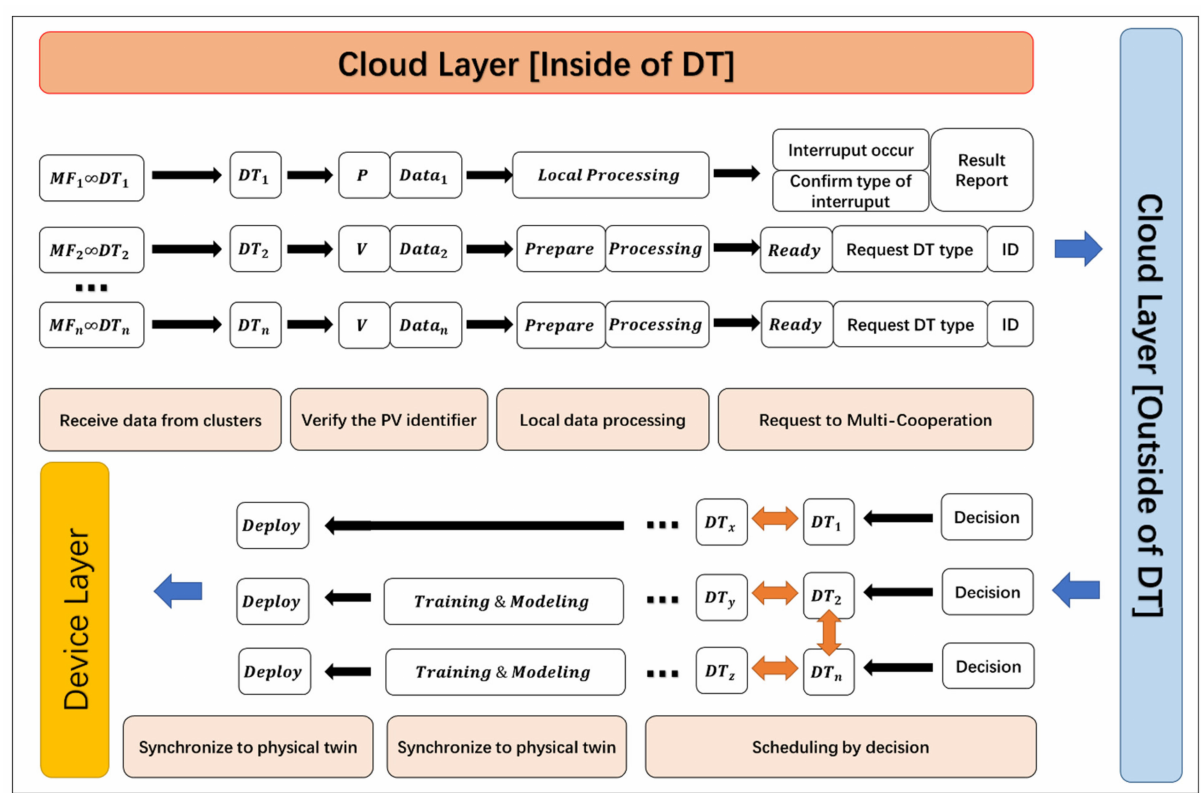
Figure 3. Flowchart of the proposed framework in the cloud layer (inside of